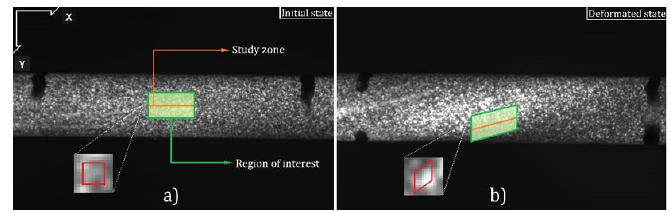
Figure 6. ( a ) Initial and ( b ) deformed DIC